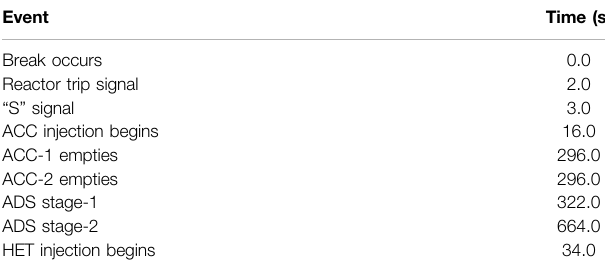
TABLE 1 | Double-ended 10-inch SBLOCA transient sequence of the